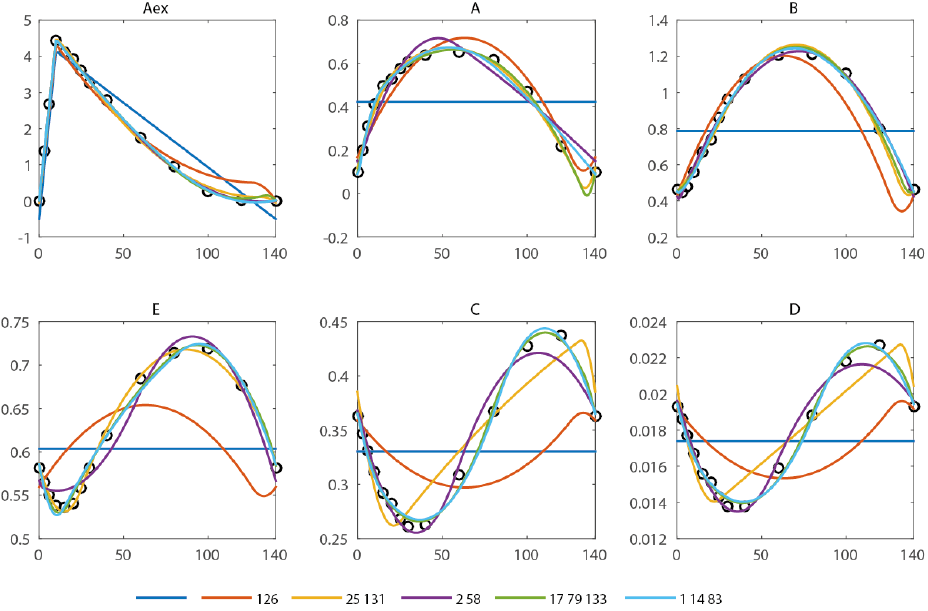
Figure 2. Approximation of the concentration measurements using piecewise affine derivatives with 0 (blue), 1 (orange), 2 (yellow and magenta) and 3 (green and light blue) free breakpoints. The respective residual sum of squared errors can be found in Table 1. Table 1. Comparison of goodness of fit for different number of breakpoints and